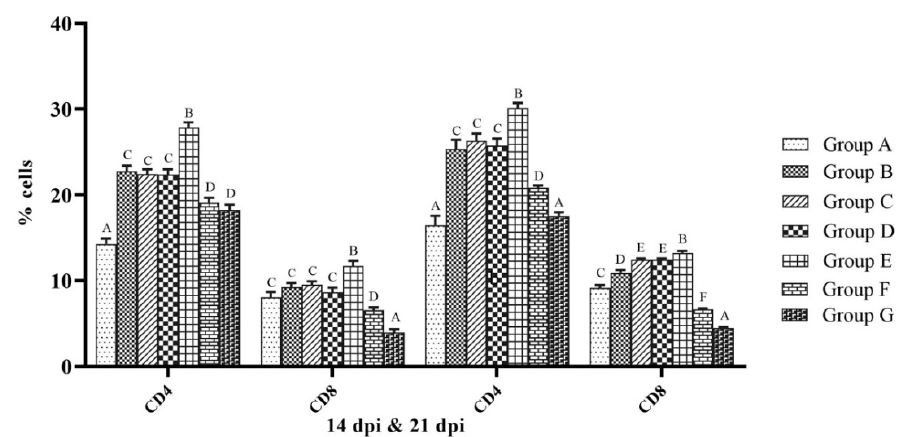
Figure 4. Percentage of CD4 + and CD8 + T cells in PBMCs collected from SPF chicken analyzed by flow cytometry. Treatment effect was analyzed at each time point by two-way ANOVA with Tukey’s test as post hoc test. The probability of an alpha error was set at 0.05. Different superscripts above bars (mean ± SE) indicate significant difference between groups ( p < 0.05). dpi: days post-NDV immunization. Group A: control; group B: commercial NDV vaccine; group C: inactivated NDV vaccine; group D: inactivated NDV vaccine with LPS; group E: inactivated NDV vaccine with R-848; group F: inactivated NDV vaccine with LPS (25 µ g) + R-848 (25 µ g) and group G: inactivated NDV vaccine with LPS (50 µ g) + R-848 (50 µ g).